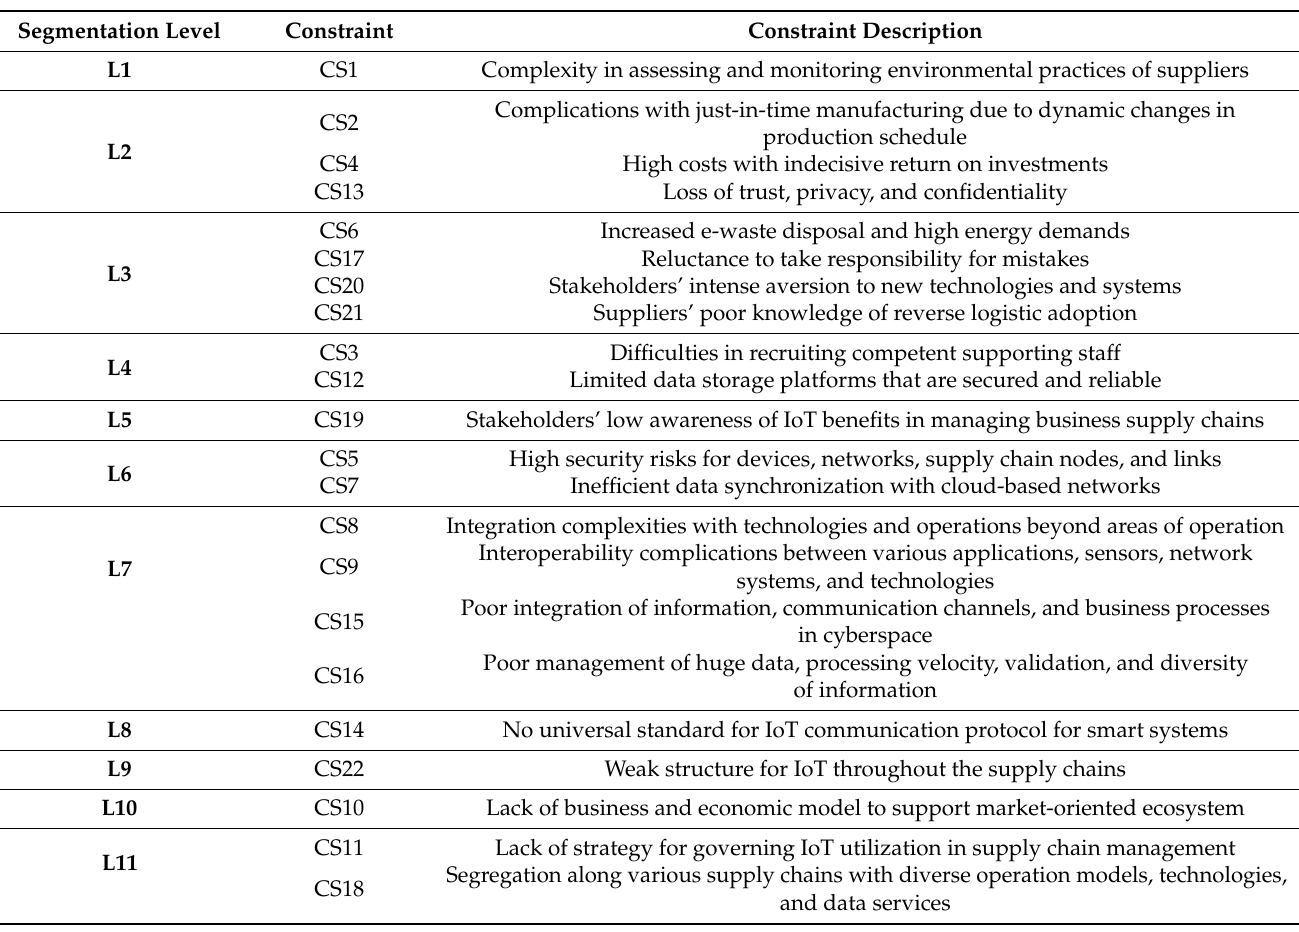
Table 4. Level segmentation for the complete